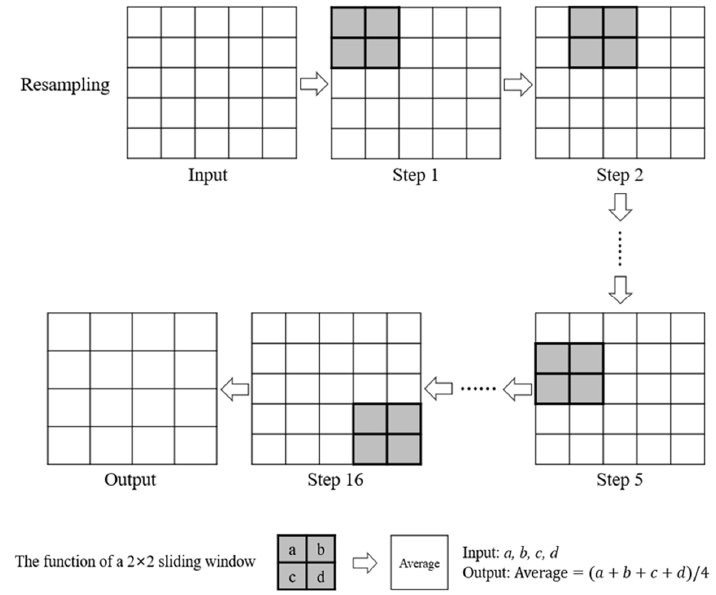
Figure 1. A diagram of the resampling technique used to generate a macrostate (output) for a landscape gradient (input; modified from Gao et al. [18]).